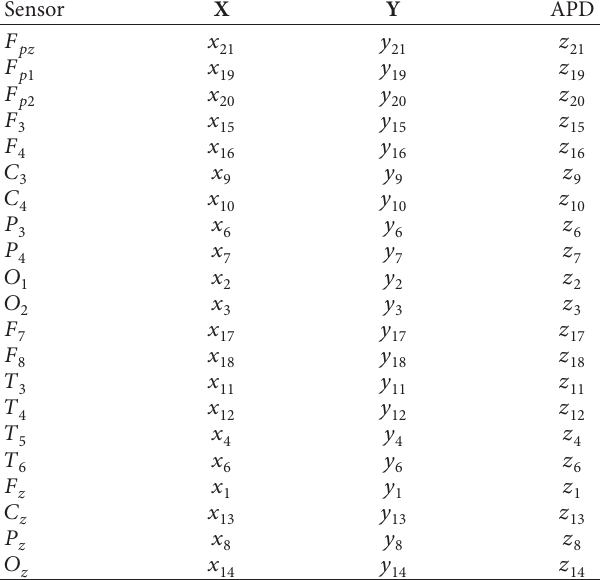
Table 2: Average potential difference (APD) at the sensor on an MC [30]. Sensor X